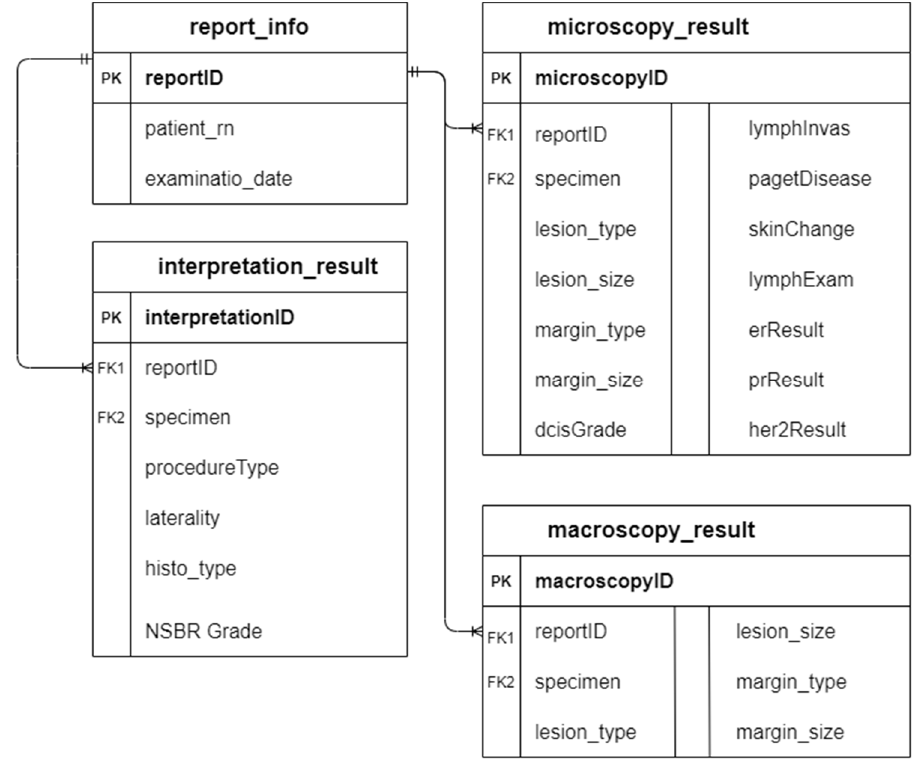
Figure 4. ERD of database for pathology reporting.